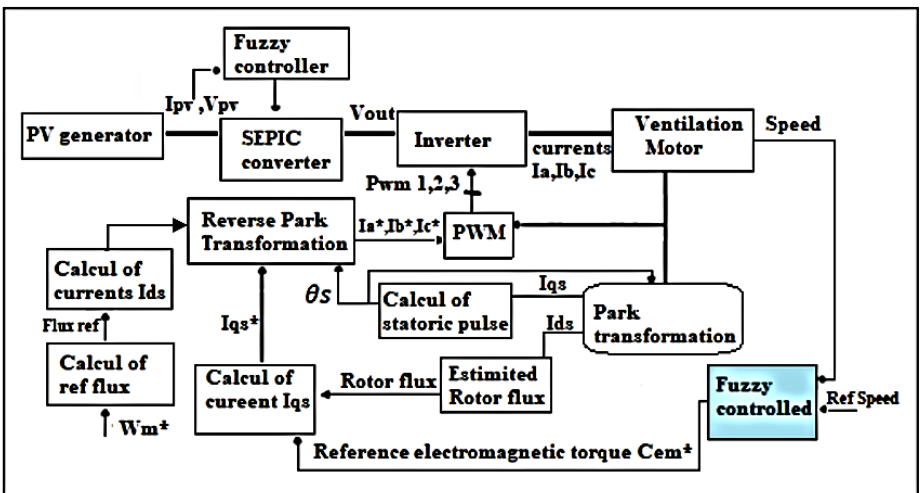
Figure 23. Structure of the optimized vector control using fuzzy logic.